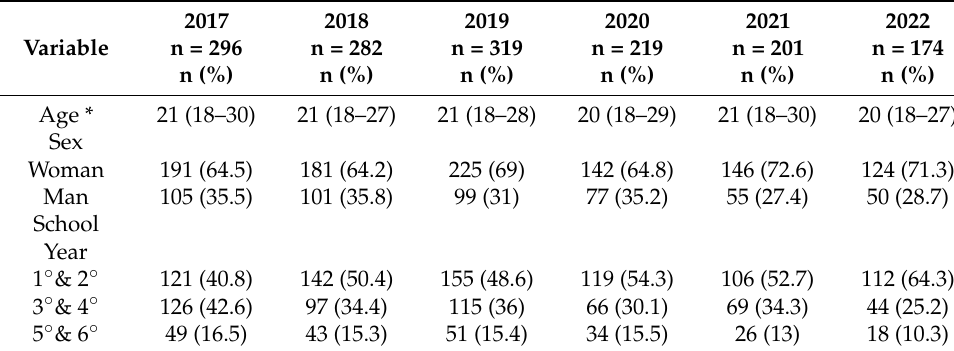
Table 1. General characteristics of each year’s sample